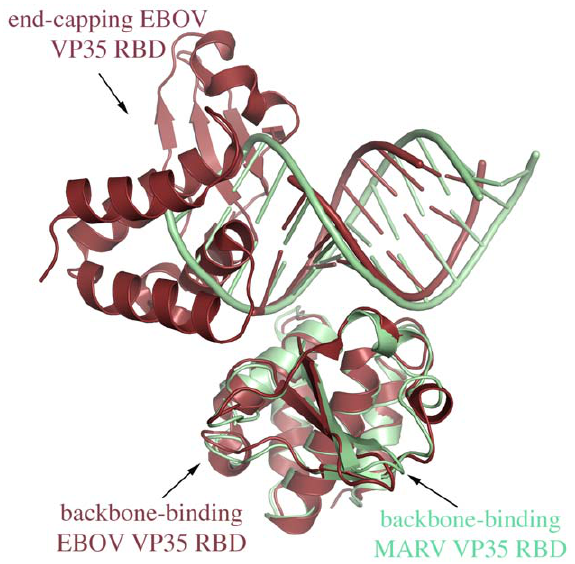
MARV-dsRNA crystal structure (green) is superimposed with that of EBOV (brick red). In the MARV crystals, all copies of VP35 in the asymmetric unit exhibit backbone binding, while in the EBOV crystals, at each end of the dsRNA, one VP35 binds the backbone while the other caps the end. Any of the four copies of MARV VP35 in the asymmetric unit superimpose with the backbone-binding VP35s of EBOV. Residues in MARV equivalent to those of the EBOV backbone- binding VP35 that form the dimer interface with the EBOV end-capping VP35, do not interact with another MARV VP35, but instead interact with the dsRNA backbone. Biophysical experiments indicate that in solution, MARV VP35 can both backbone-bind and end-cap, so the differences depicted here may be differences between complexes captured in different crystal packing arrangements, rather than inherent differences between MARV and EBOV.